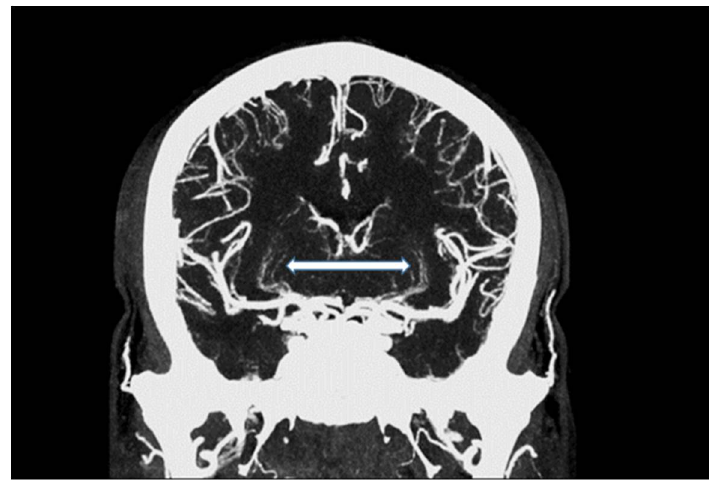
Figure 2. Maximum intensity projection of an intracranial UHR-CTA, depicting traceability of lenticulostriate arteries (LSA; white arrow).